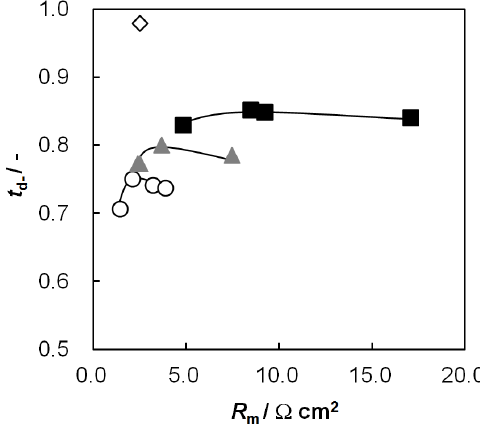
, of AEMs as a function of membrane Figure 7. Dynamic state transport number, t d − resistance, R . The definition of symbols in this figure is the same as in Figure 2. Open m diamond represents the data of the commercially-available AEM, Neosepta AMX (ASTOM Corp.: Tokyo,